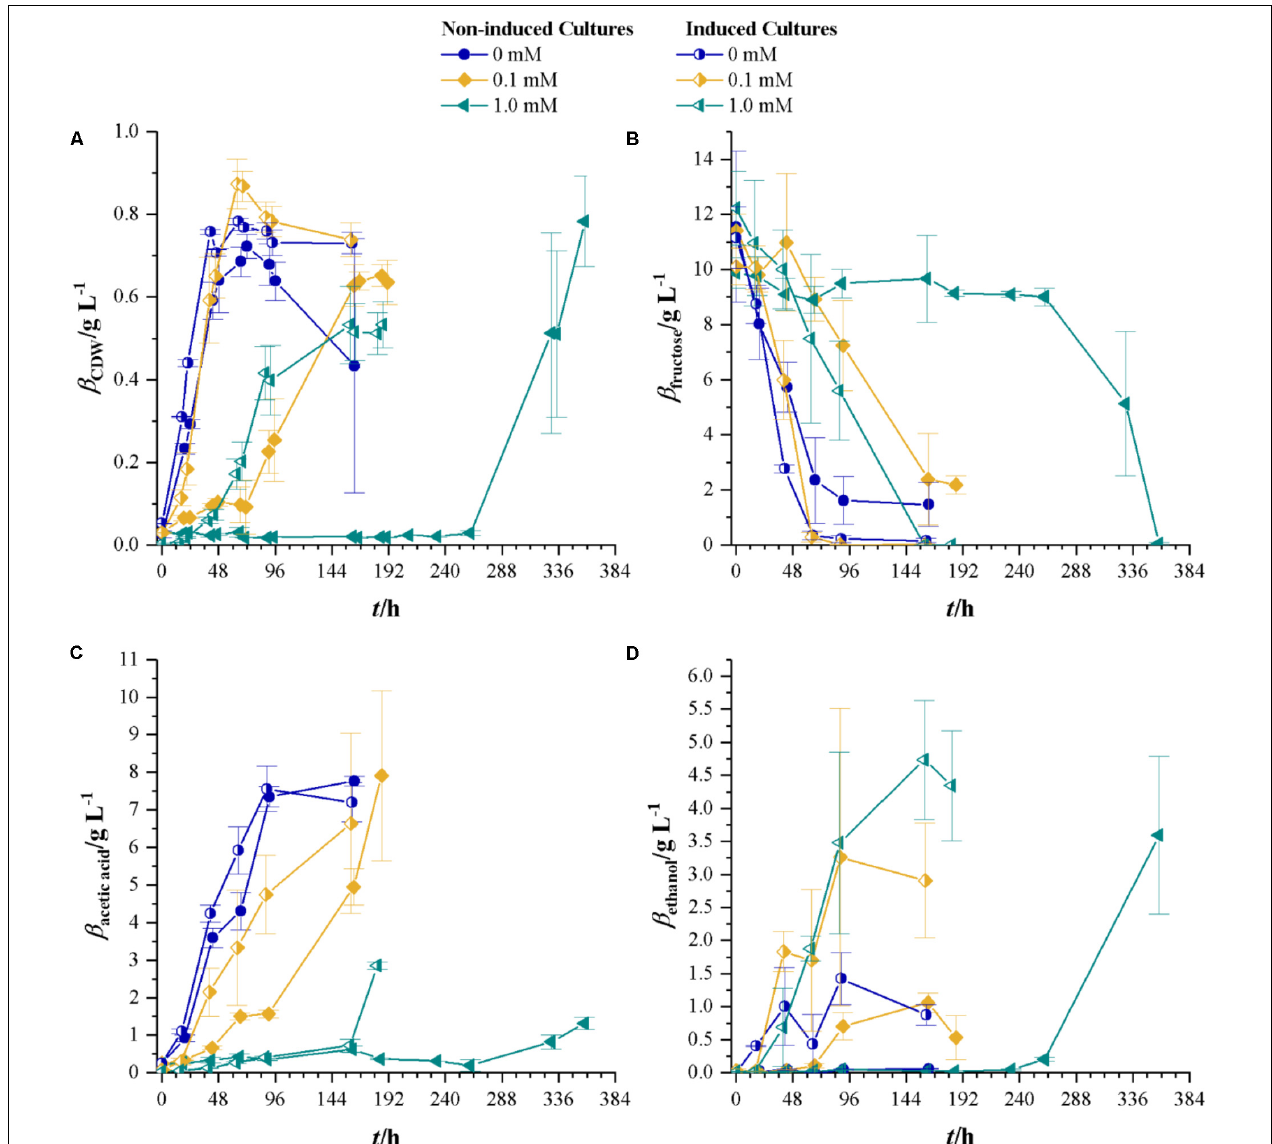
FIGURE 3 | Non-induced C. ljungdahlii (full symbols) vs. the induced strain (half-filled symbols) at different cyanide concentrations with fructose as a carbon source. Cyanide concentrations are 0 (blue dots), 0.1 (yellow diamonds), and 1.0 mM (petrol tilted triangles). (A) CDW; (B) mass concentration of fructose; (C) mass concentration of acetic acid; and (D) mass concentration of ethanol. Average values of three independent cultivations. All experiments are conducted in